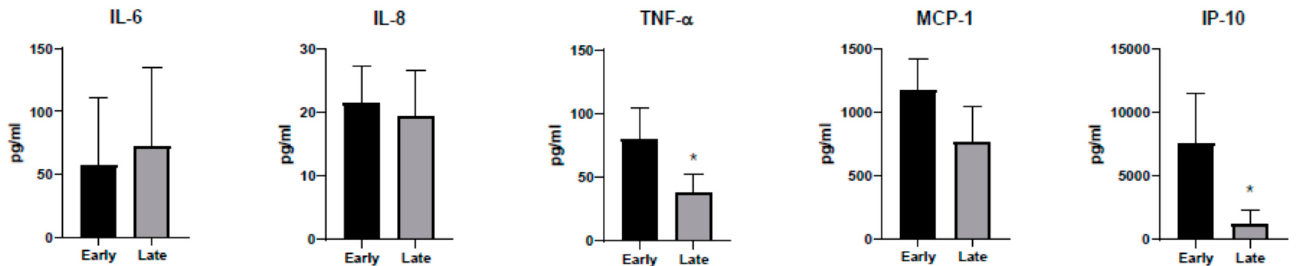
Figure 5. Effect of stage of infection on cytokine concentrations. Average cytokine values in early and late infection groups are shown as geometric mean with 95% CI. * represents a significant difference from the early group ( p < 0.01). For monocyte chemoattractant protein-1 (MCP-1), the p value was 0.011.